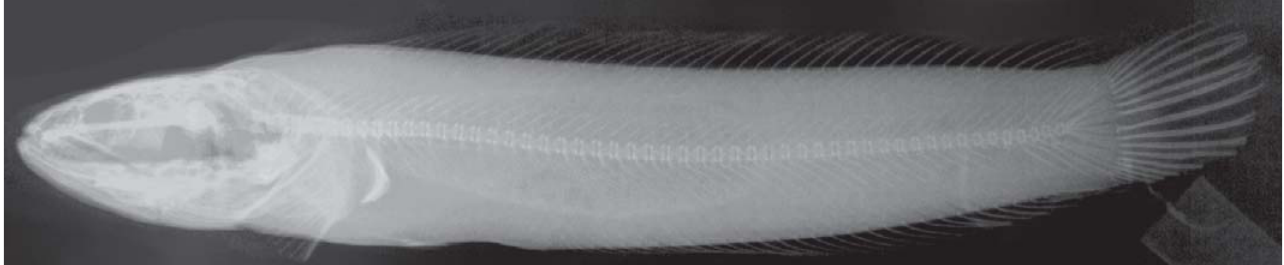
Image 3. Radiograph showing skeleton of Channa aurantimaculata (MUMF-Per/0001, 131.2mm SL)